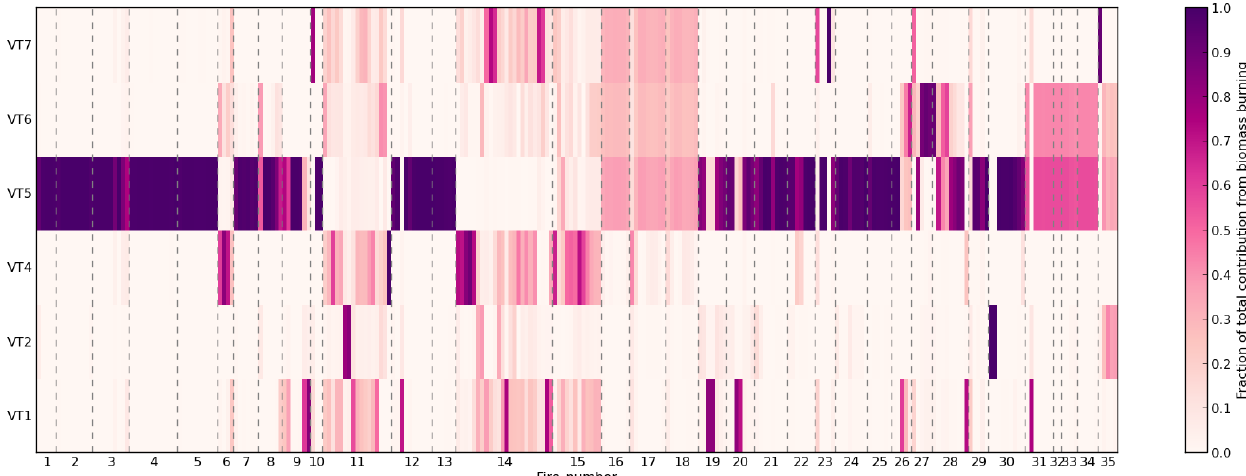
Figure 4. Daily fractional GEM concentration contributions of the six vegetation types to the 35 fire events. Values closer to 1 (dark purple) indicate that more of the fires were in that vegetation type. The horizontal dotted lines separate the 35 fire events; wider gaps indicate fires that took place over a longer time frame.